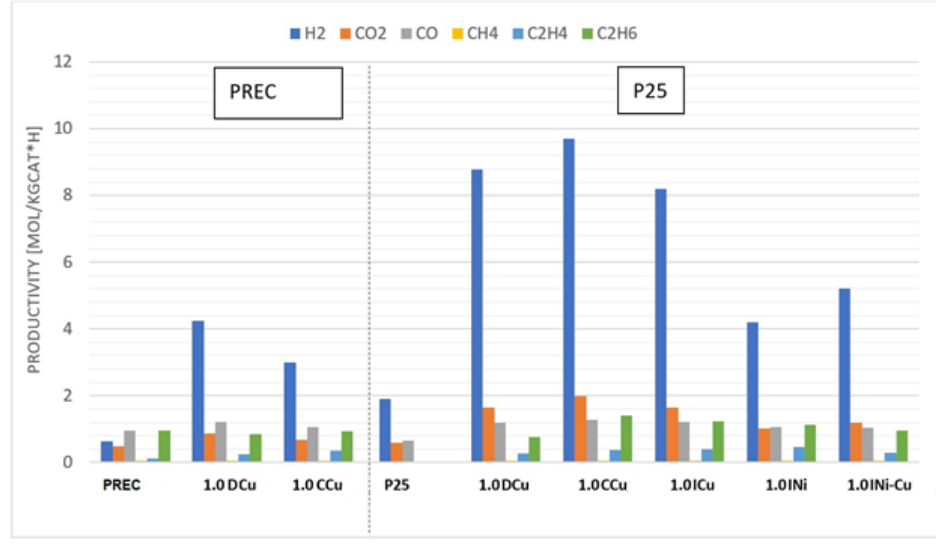
Figure 12. Productivity of various gas phase products obtained with 1 wt % CuO loaded by di ff erent methods (I, D and C) over PREC and P25.